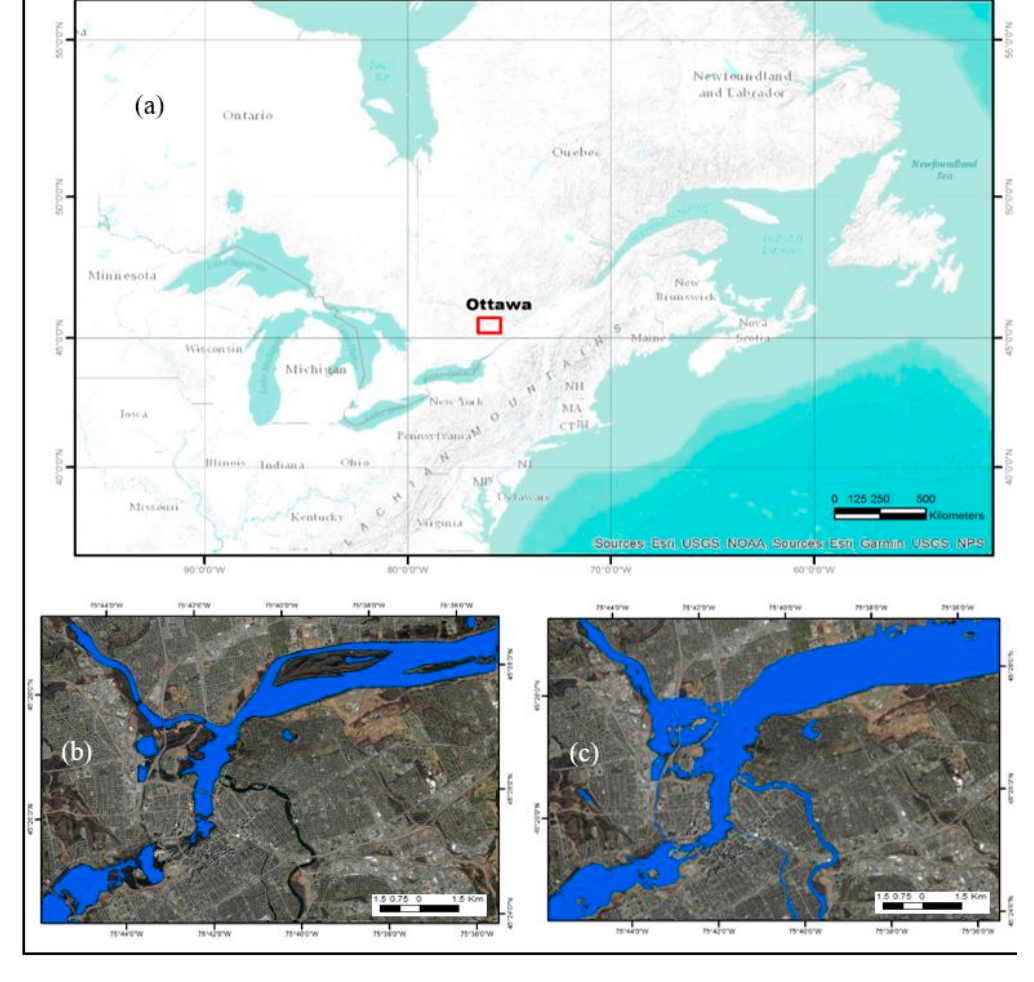
Figure 1. ( a ) Location of study area in the North America map, ( b ) Ottawa and Gatineau River extents before flood (9 May 2018), ( c ) Flood extent on the Ottawa and Gatineau Rivers in Ottawa, Canada (10 May 2018), recorded by the International Charter: Space and Major Disasters. Flood and river extents are produced by Natural Resources Canada (NRC) based on RadarSat-2